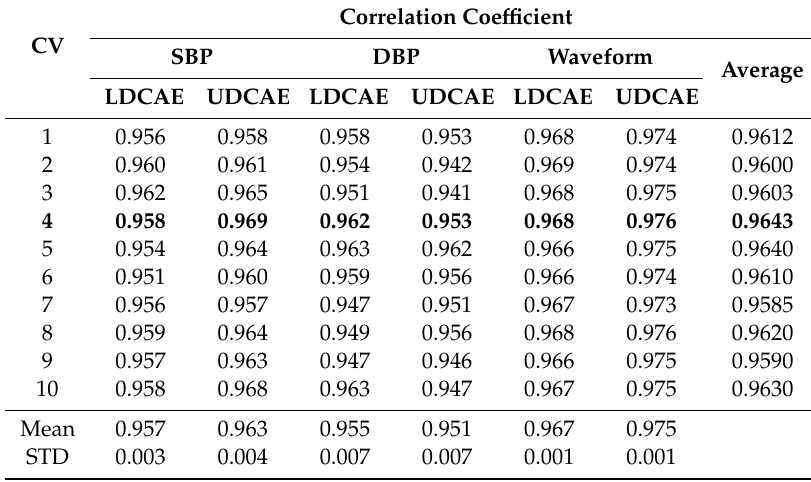
Table 1. The Pearson’s Linear Correlation Coefficient Evaluation of LDCAE and UDCAE Models from the Cross-Validation (CV) Method. Note: bold value is the best single CV model.